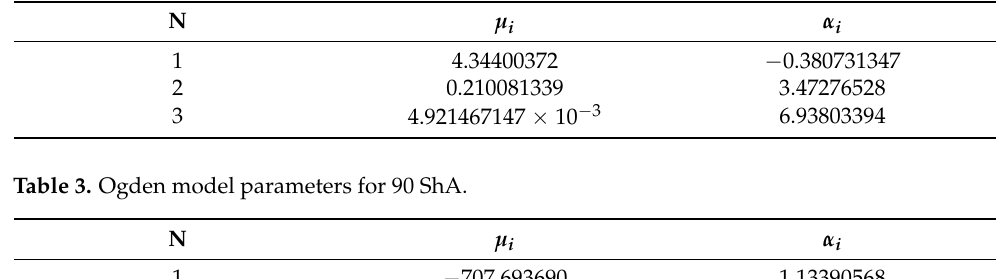
Table 3. Ogden model parameters for 90 ShA.